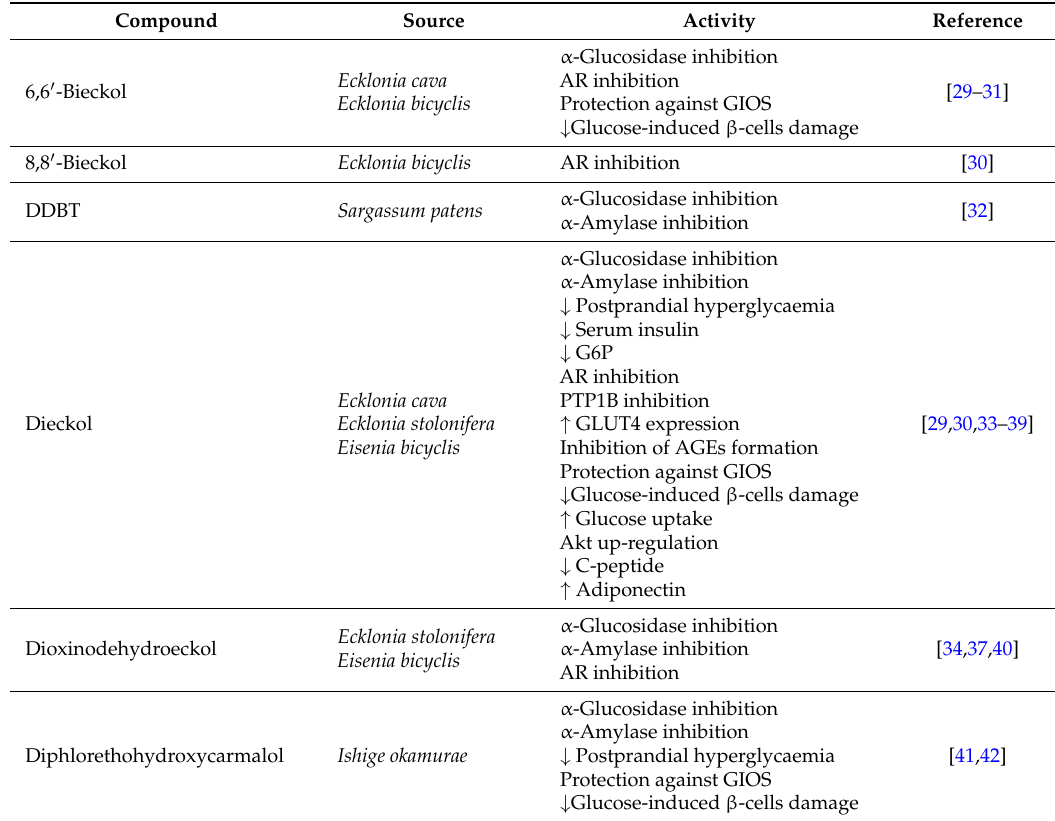
Table 1. Antidiabetic activity of isolated phlorotannins